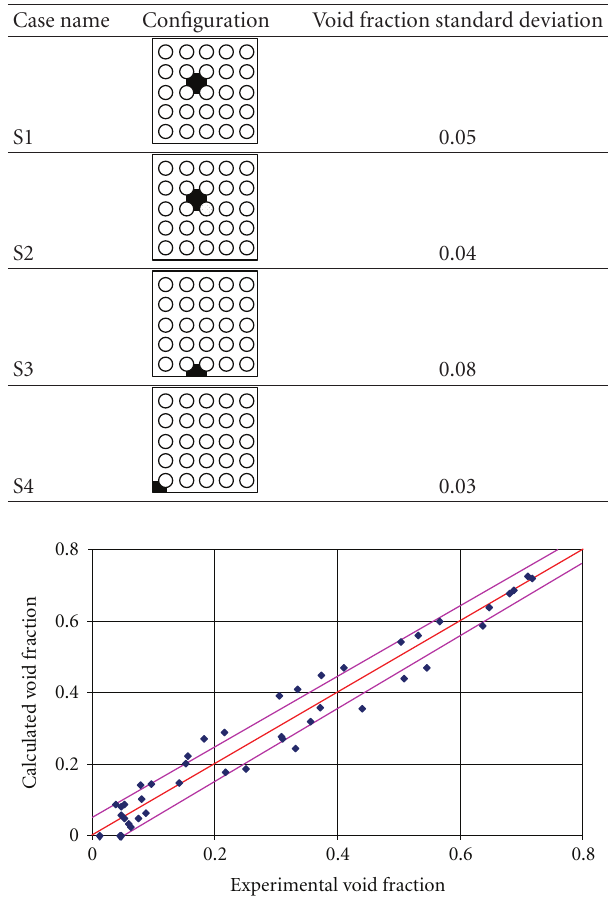
Figure 1: Comparison between calculated and measured void frac- tion for subchannel type S1.